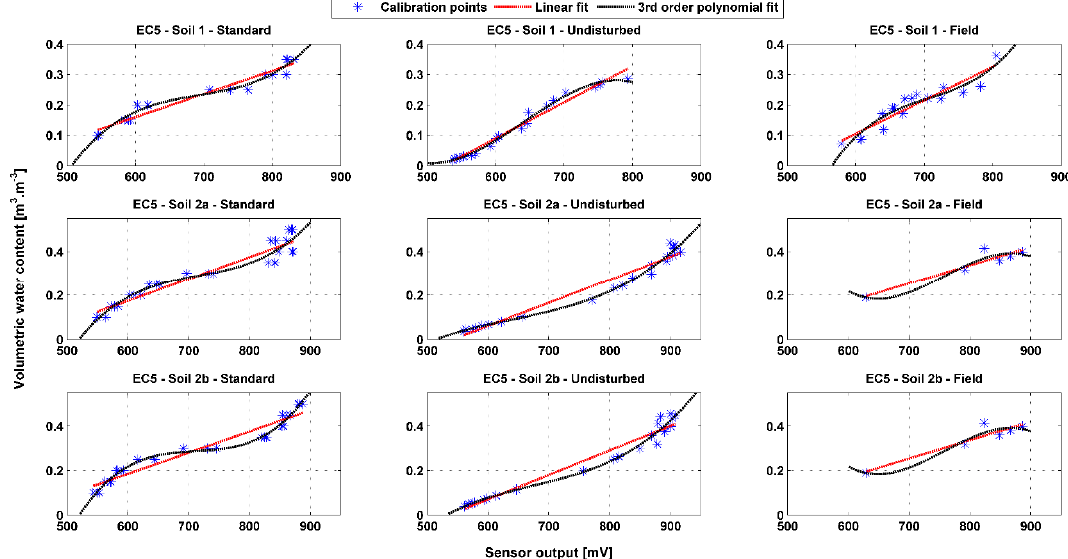
Figure A1. Linear and third-order polynomial fitting curves to EC5 sensor calibration data obtained by means of standard, undisturbed and field methods on soil 1, 2a and 2b.